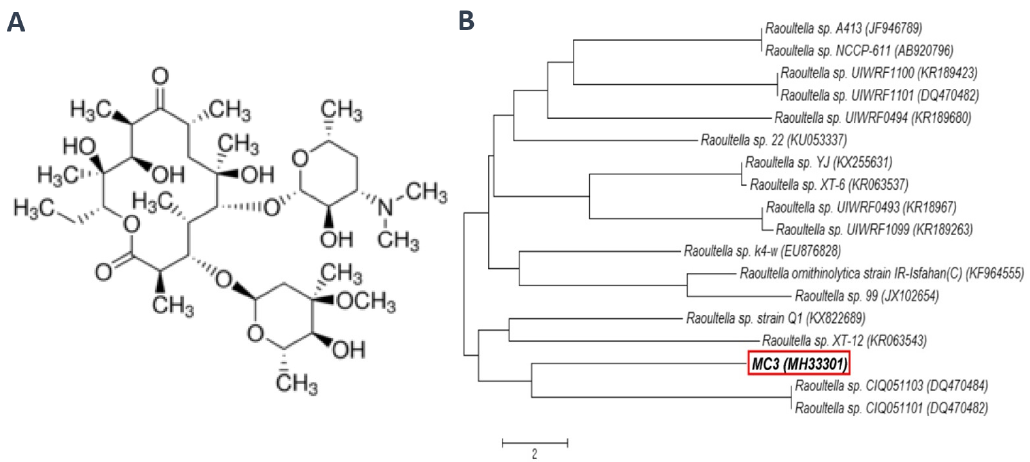
Figure 1. Chemical structure of erythromycin ( A ) and phylogenetic tree of Raoultella sp. strain MC3 ( B ).